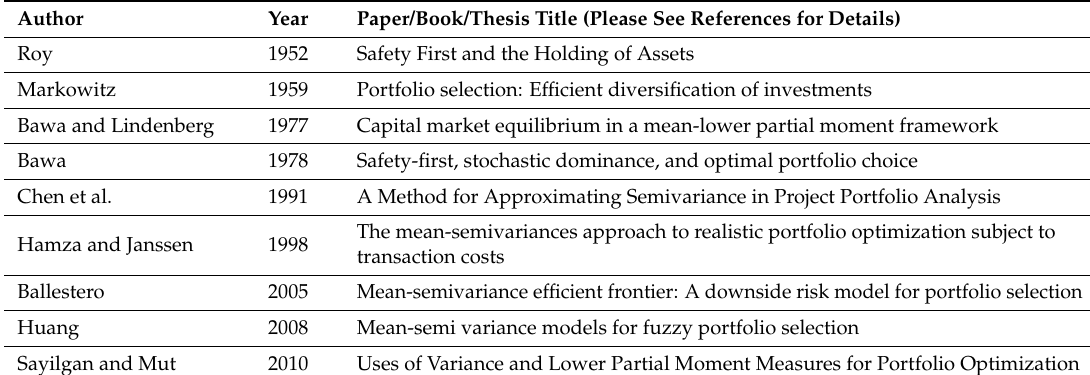
Table 5. Selected work on Portfolio Selection and Semi